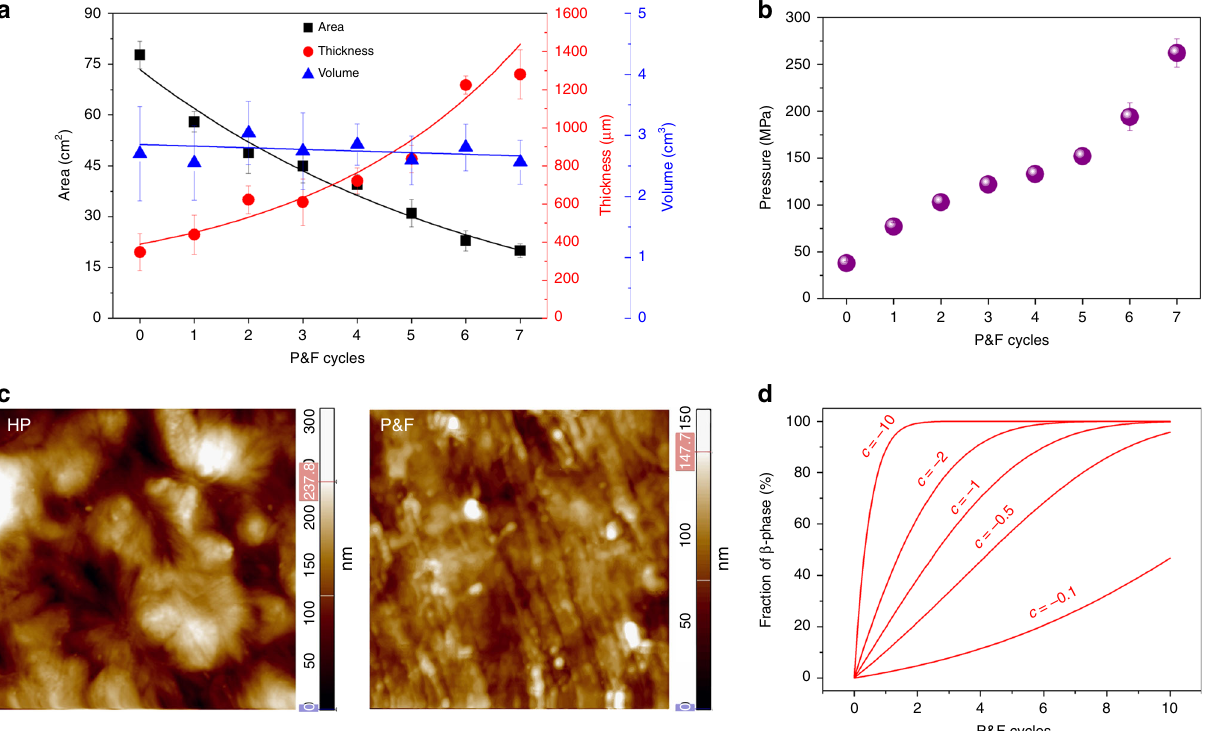
Fig. 2 Morphological changes of poly(vinylidene fl uoride) samples. a Variation of overall sample area, thickness and volume with the number of P&F cycles. b Calculated pressure (nominal stress) in purple data points for different P&F cycles. c AFM topography images (5 µ m × 5 µ m) of initial HP (left) and P&F (right) after seven cycles, which show the evolution of morphology, from large spherulites in HP fi lms to small granules after P&F fi lms. d Theoretical changes of the β -phase content according to Eq. 2 with different values of parameter